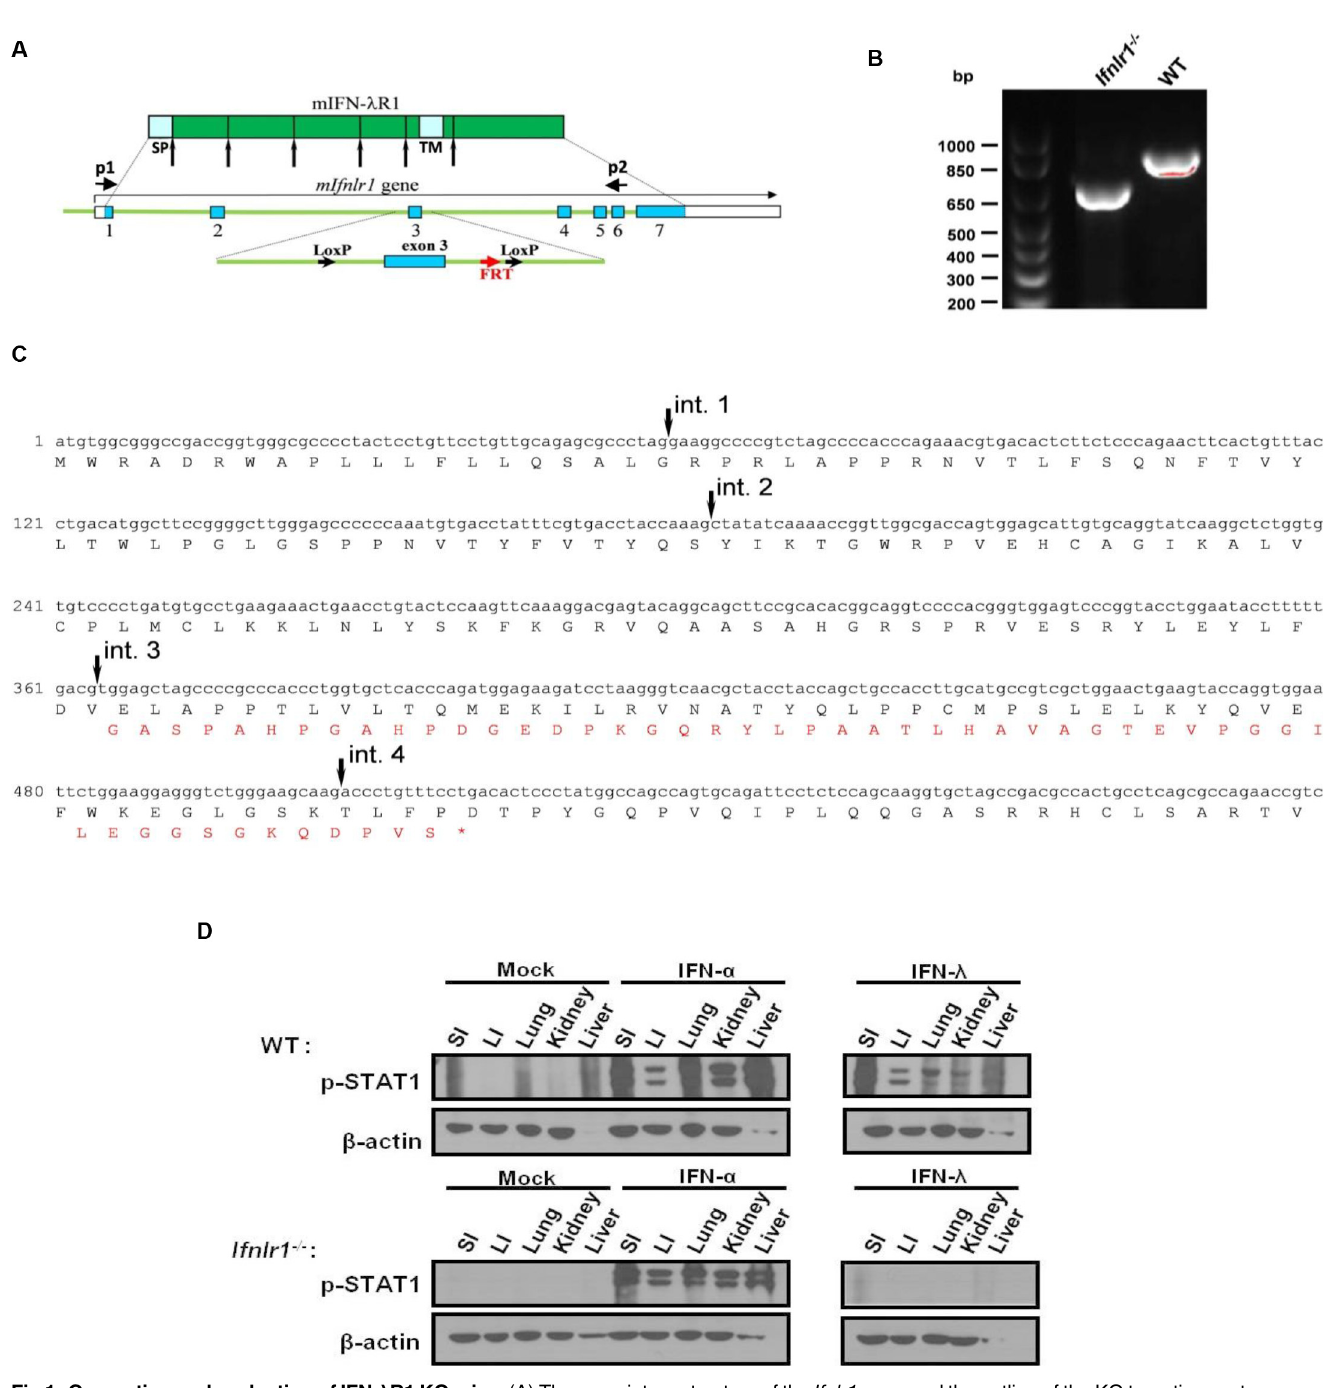
PLOS Pathogens | DOI:10.1371/journal.ppat.1005600 April 29,